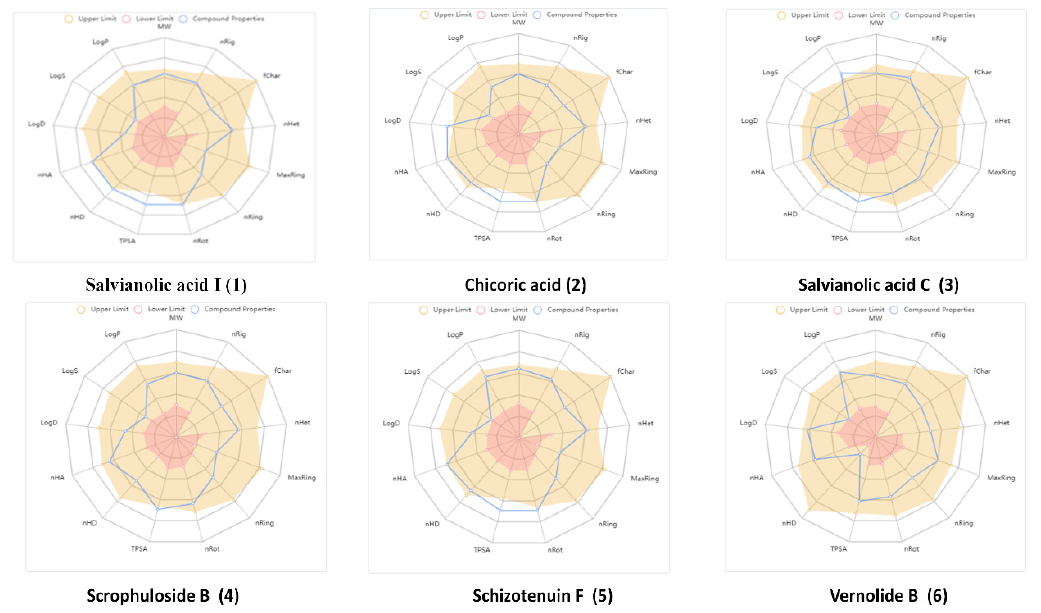
Figure 3. Radar plot demonstrating physicochemical properties of hit compounds. Brown Area: Up- per Limit for each property, Blue area: Compound Property, Pink area: Lower limit of Physiochemical Property. Table 4. Table of physicochemical properties of six hit